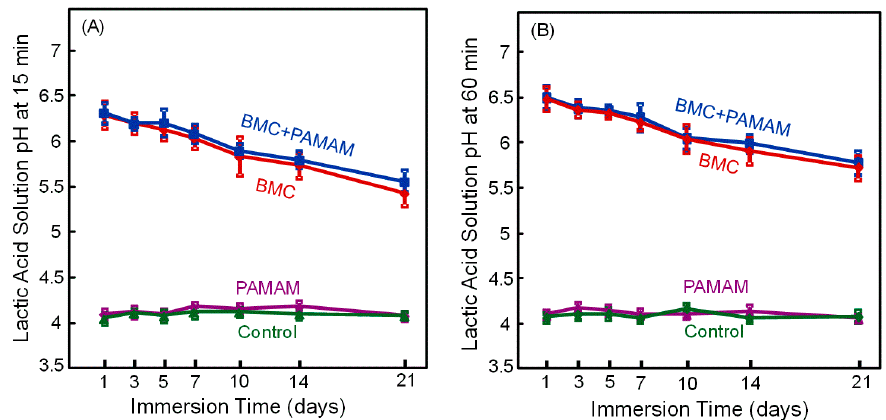
Figure 3. Acid neutralization. The pH of lactic acid solution was measured after the specimen was immersed for: ( A ) 15 min, and ( B ) 60 min (mean ± SD; n = 6). This was done for 21 days. The BMC group and BMC + PAMAM group neutralized the acid and raised the pH. PAMAM and control groups had no acid neutralization and the pH stayed near 4.